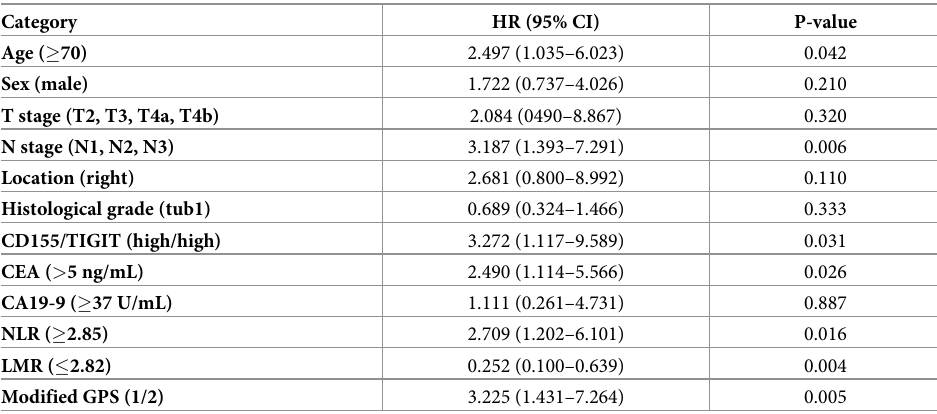
Table 4. Univariate analysis for overall survival.